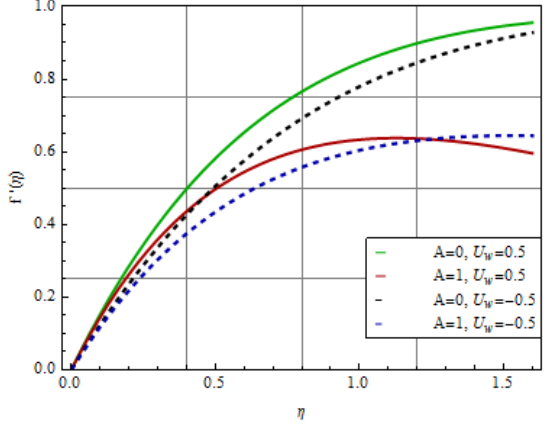
Fig. 13: The velocity distribution for alumina-sodium alginate nanofluid for different values of magnetic and wall transpiration parameters with A = 0.5, ε = 0, λ = 1, Pr = 6.2, ϕ = 0.2.